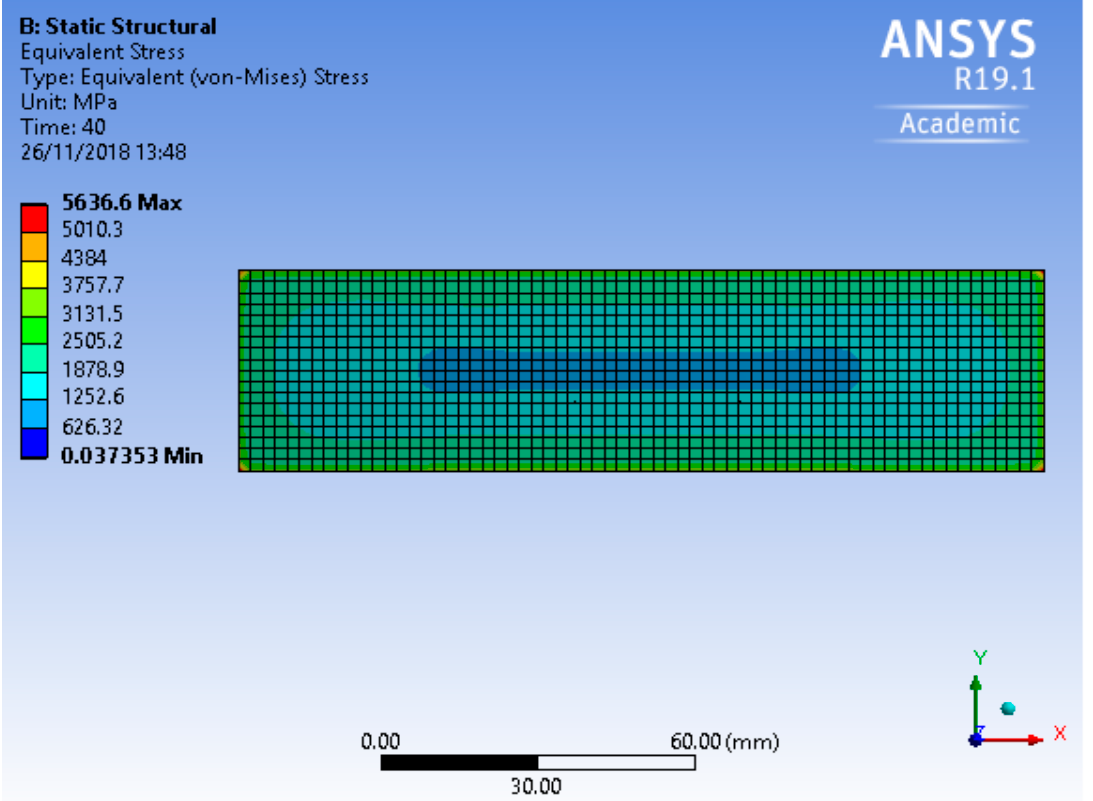
Figure 7. Hot plate showing thermal stress.